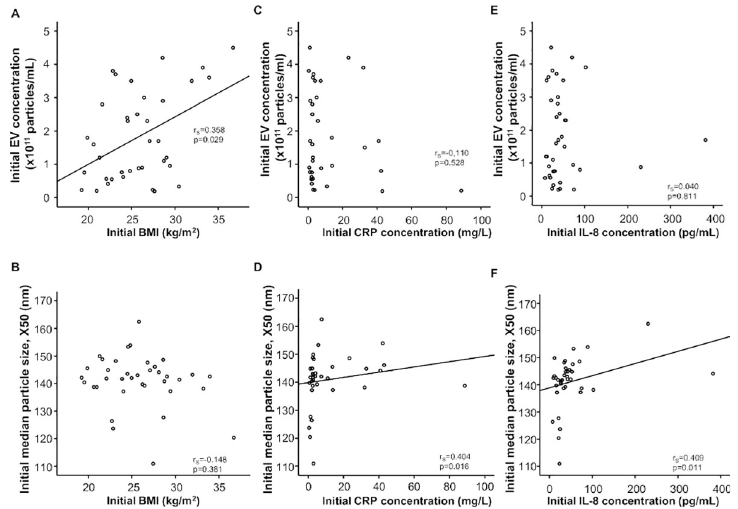
Fig 2. EVS size (X50) positively correlates with markers of inflammation before TACE. (A) Initial BMI significantly correlates with initial EVs concentration. (B) BMI does not correlate with initial median particle size (X50). (C) Initial EVs concentration does not correlate with CRP-concentration. (D) Initial CRP-concentration significantly correlates with initial median particle size (X50). (E) Initial EVS concentration does not correlate with IL- 8-concentration. (F) Initial IL-concentration significantly correlates with initial median particle size (X50).